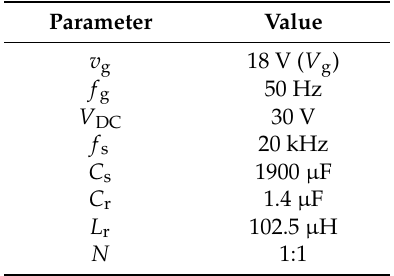
Table 1. Parameters of the MATLAB Simulink model.